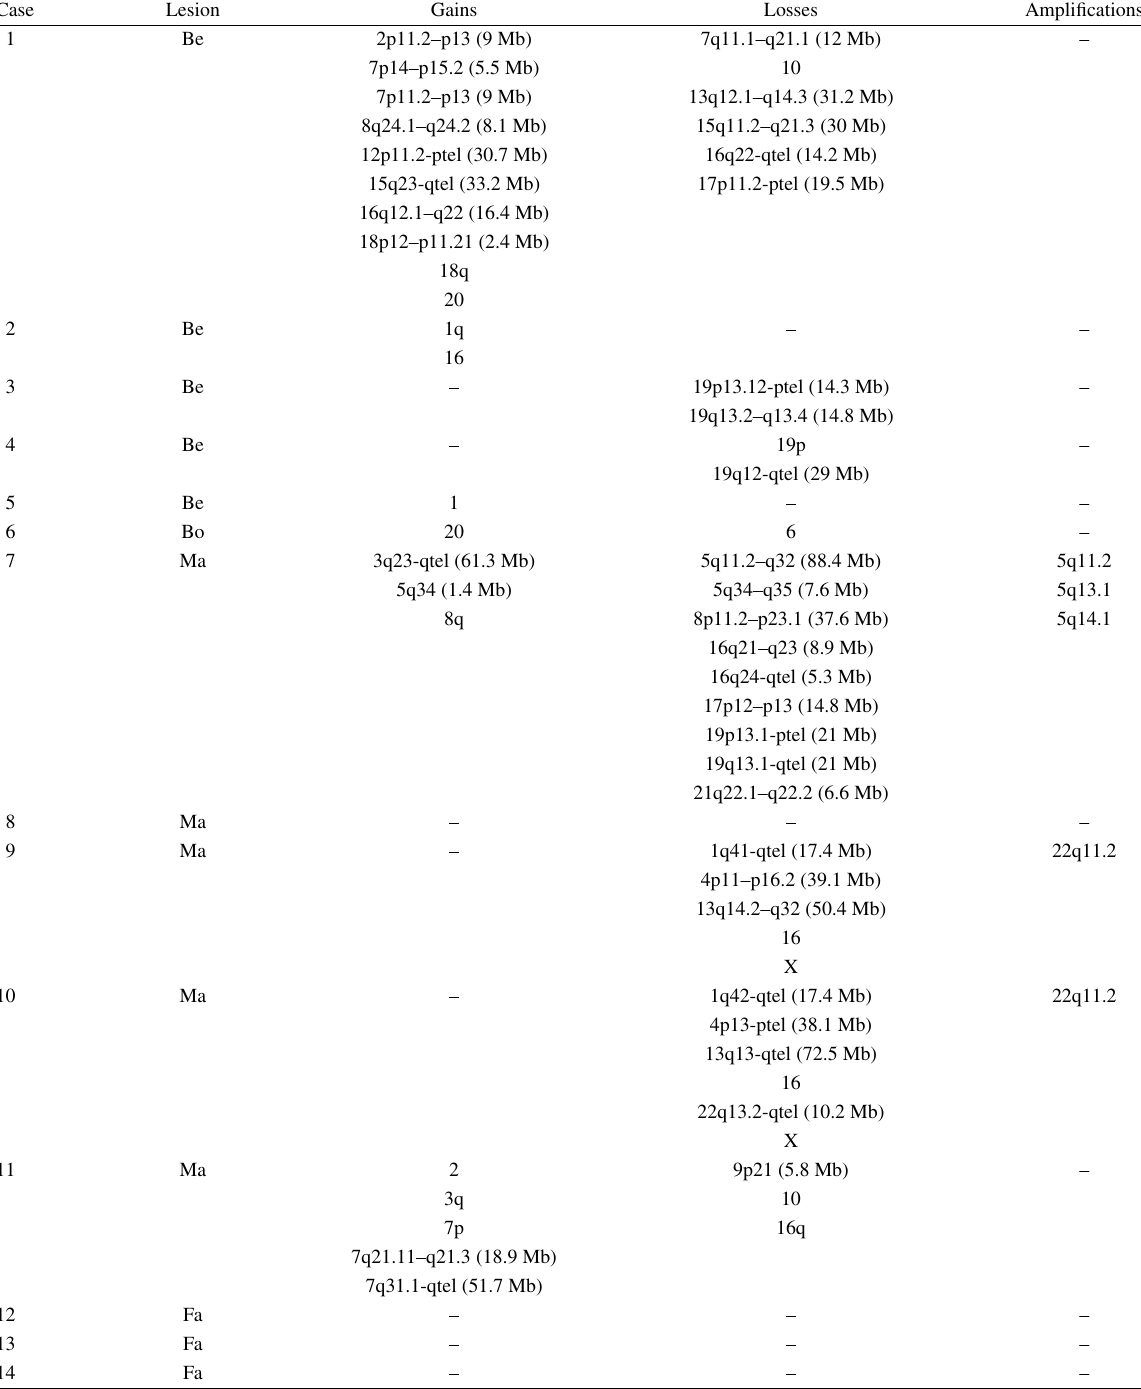
Summary of DNA copy number changes in fibroepithelial breast